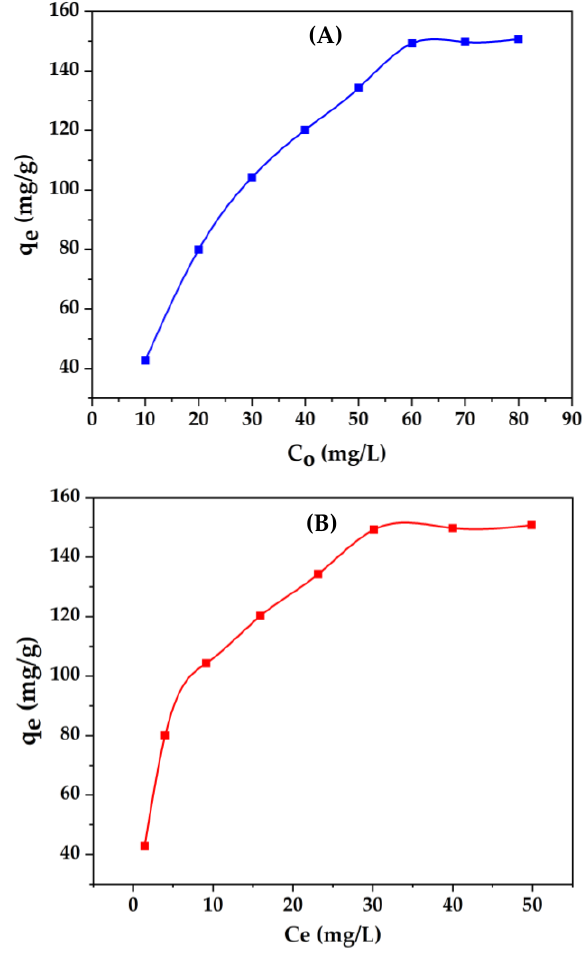
Figure 4. Effect of initial concentration (C o ) on equilibrium adsorption capacity q e ( A ) and equilibrium adsorption capacity vs. equilibrium concentration (C e ) ( B ).